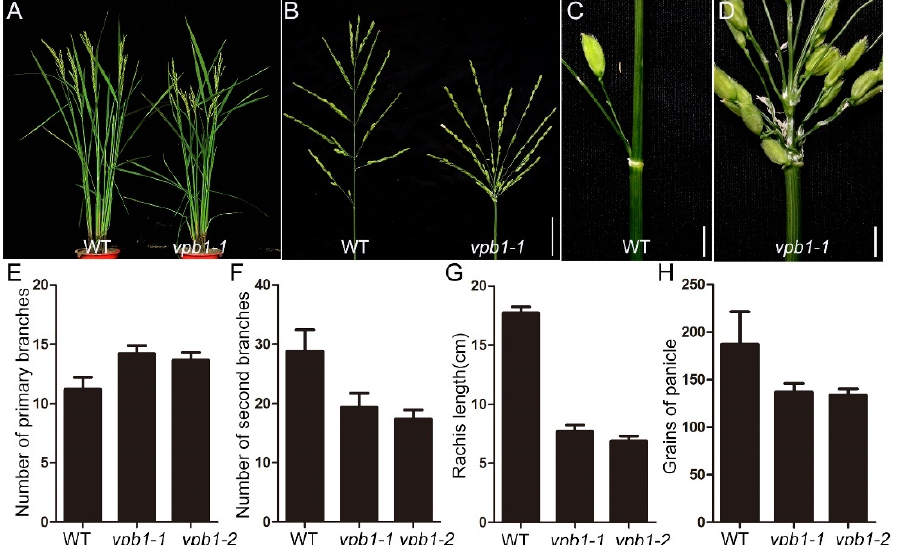
Figure 1. Phenotypic characterization of vpb1-1 mutant. ( A ) Mature wild-type plants (left) and the vpb1-1 mutant (right). ( B ) Mature panicles of wild-type (left) and vpb1-1 mutant (right). ( C , D ) Close-up view of the branch site of the primary branches in wild-type ( C ) and vpb1-1 mutant ( D ). ( E – H ) Quantitative traits of wild-type and vpb1 mutant panicles. Vertical bars indicate standard deviations, n = 15. ( E ) The numbers of primary branches in wild type and vpb1 mutant. ( F ) The numbers of secondary branches in wild type and vpb1 mutant. ( G ) Rachis length of wild type and vpb1 mutant. ( H ) The numbers of grains of panicle in wild type and vpb1 mutant. Scale bars, 4 cm in ( B ); 2 cm in ( C , D ).